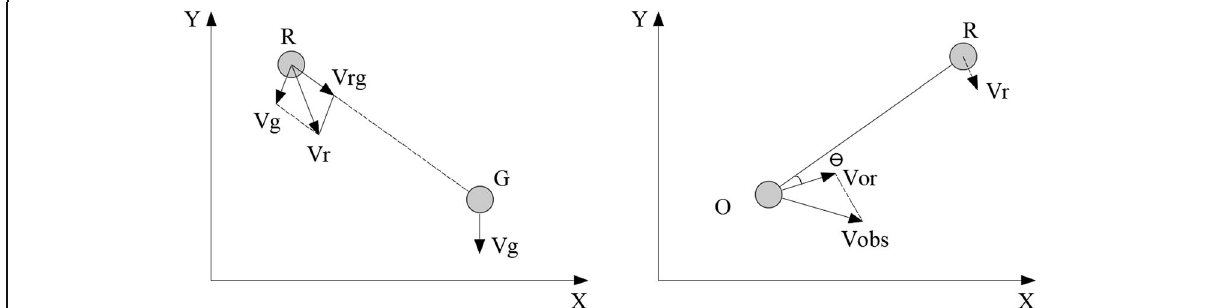
Fig. 3 Velocity decomposition of robot in gravitational field and its state of motion with